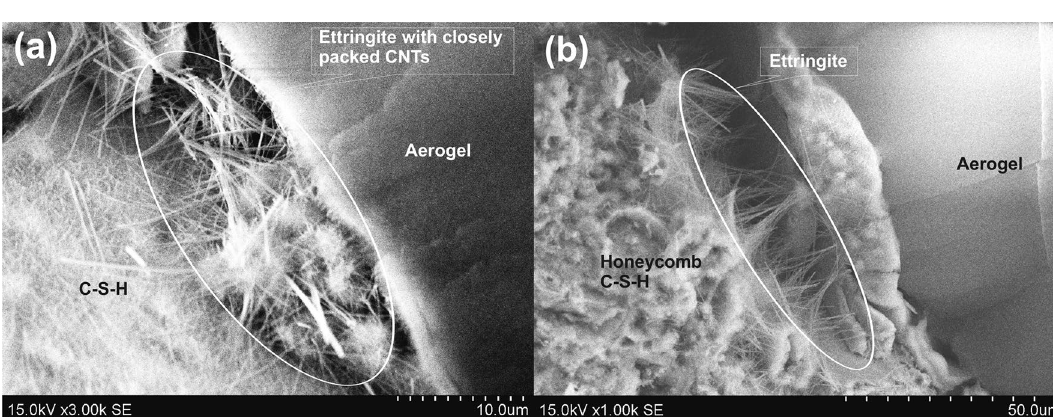
Figure 7. Agglomeration of CNTs and presence of ettringite and honeycomb structure of C–S–H gel in the transition zone of aerogel and cementitious material.